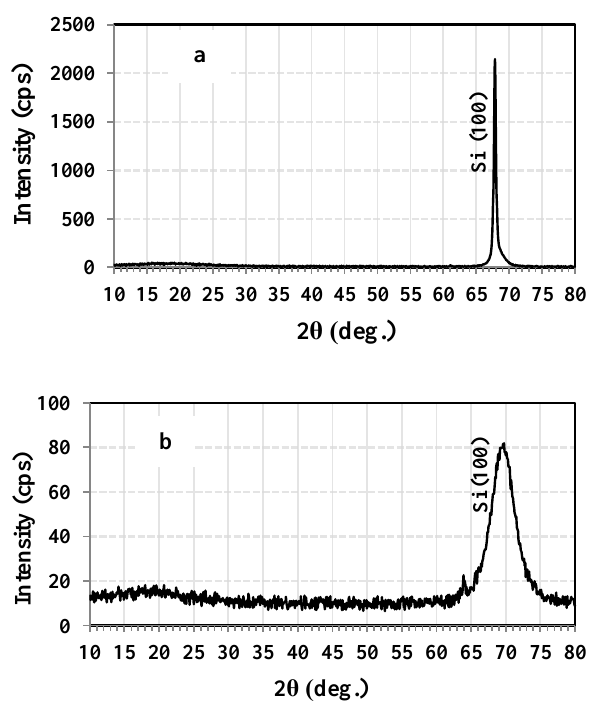
Fig. 4: XRD for (a) bulk Si and (b) PS